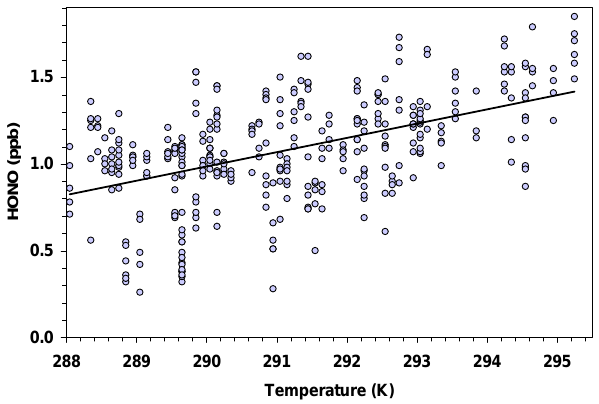
Fig. 8. Temperature dependence of HONO measured at Saturna Island during the PSS time period: 22:00–05:00. The equation of the linear line is C HONO = 0 . 082 ( ± 0 . 007 ) × T − 22 . 8 ( ± 2 . 1 ) ppb; R 2 = 0 . 25. The positive temperature dependence is statistically sig- nificant (95% confidence level). The corresponding temperature co- efficient of the dependence in the middle of the temperature range (292K) is ( 1 /C HONO )dC HONO /dT =+ 7 . 2% ( ± 0 . 6% ) K − 1